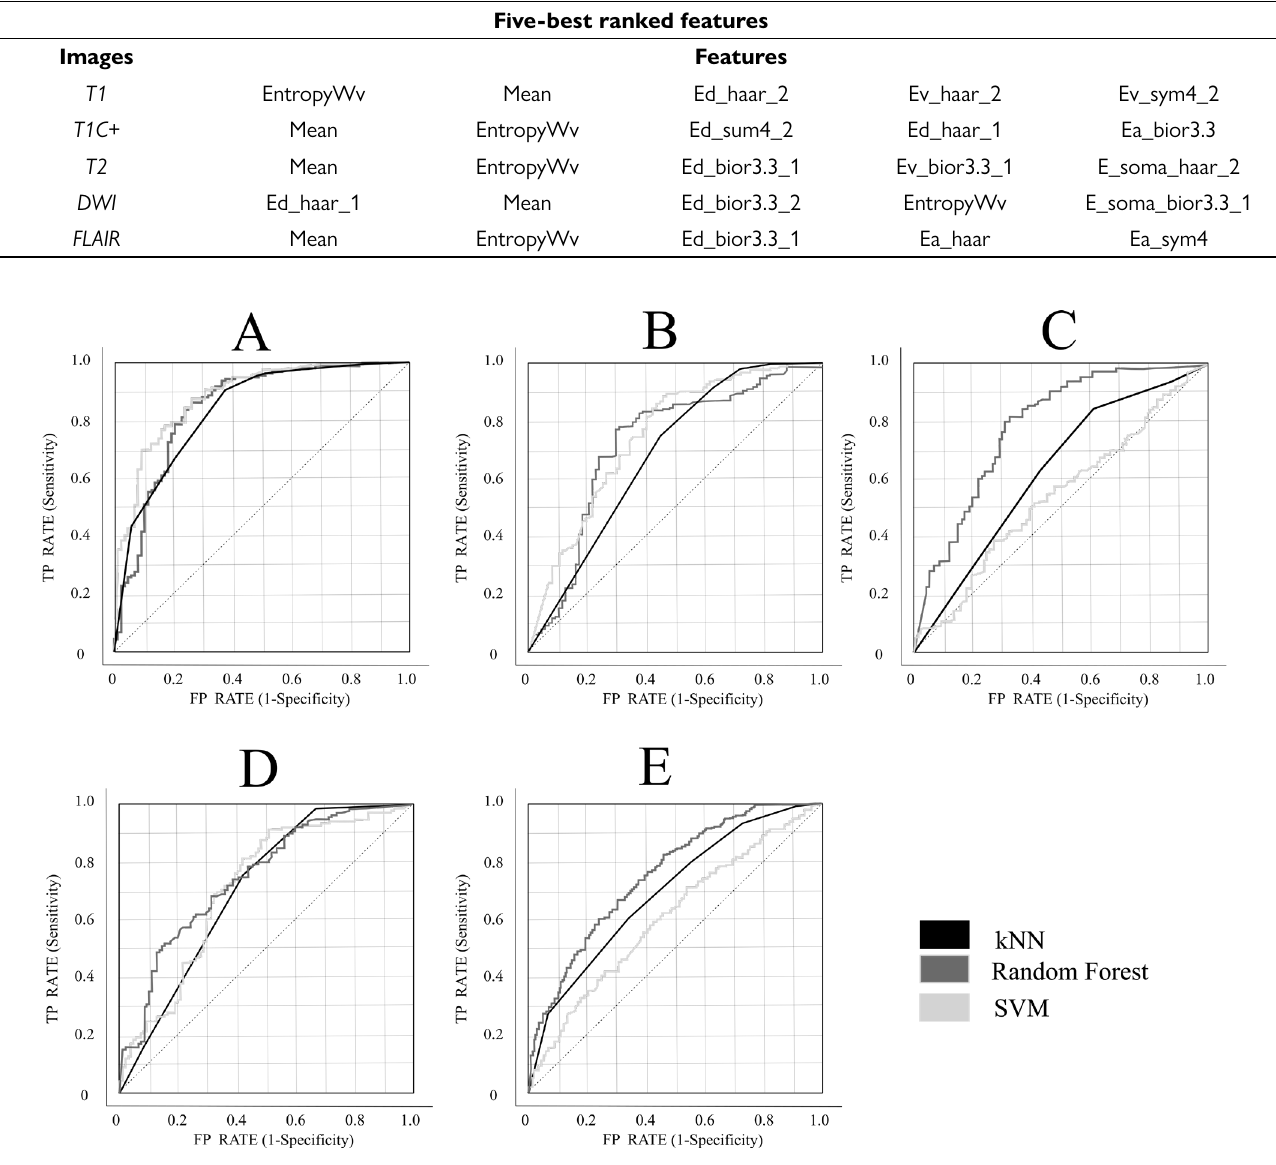
Table 3. The five best-ranked features in each MRI sequence, being T1-weighted sequence (T1), T1-weighted sequence with contrast medium (T1C+), T2- weighted sequence, diffusion-weighted image sequence (DWI), and FLAIR.